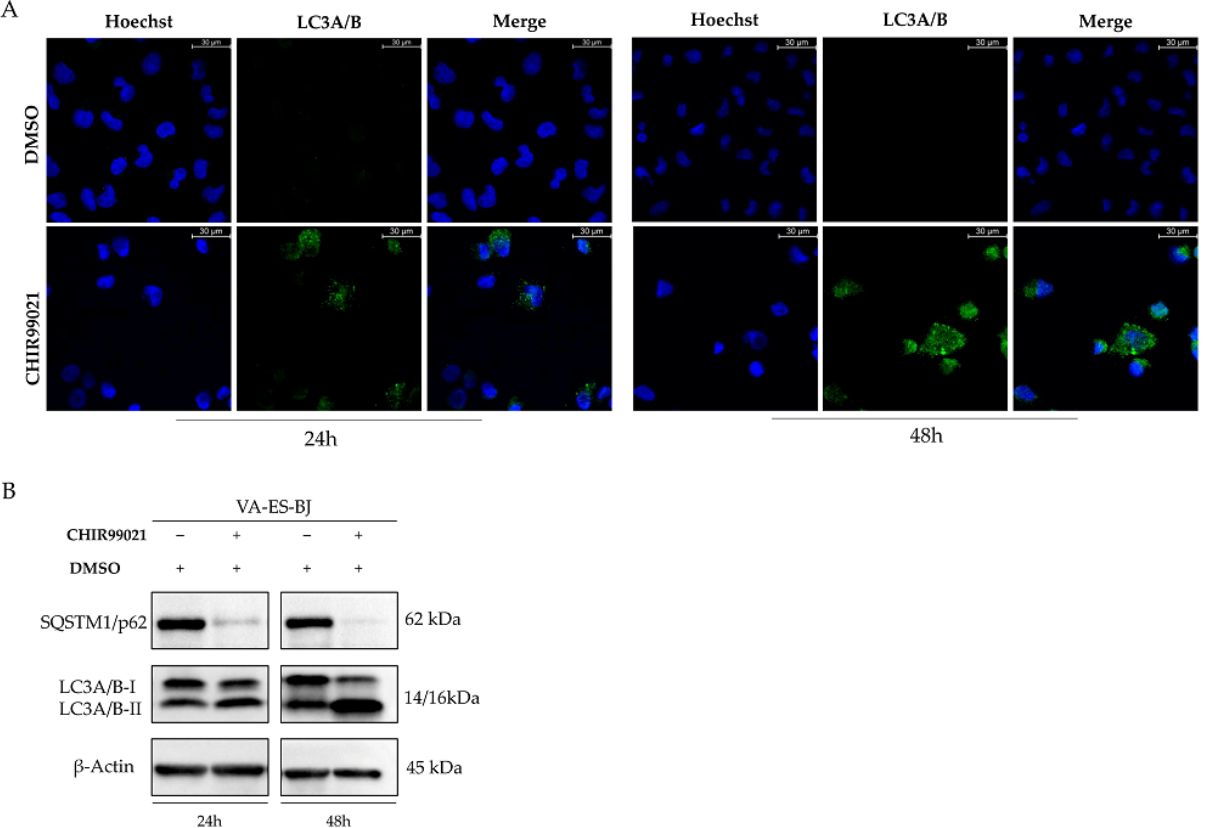
Figure 6. CHIR99021 induces autophagy in the VA-ES-BJ cell line. Cells were treated with CHIR99021 100 µ M for 24 or 48 h and detecting LC3A/B levels by immunofluorescences. ( A ) Increase of LC3-positive puncta formation supported the involvement of autophagy in VA-ES-BJ cells. ( B ) Western blot analysis reporting the expression levels of protein related to autophagic process at 24 and 48 h after CHIR99021 100 µ M treatment. The blot was first incubated with anti-LC3A/B and then reprobed with anti- β -Actin to confirm the equal loading of each lane (60 µ g of whole